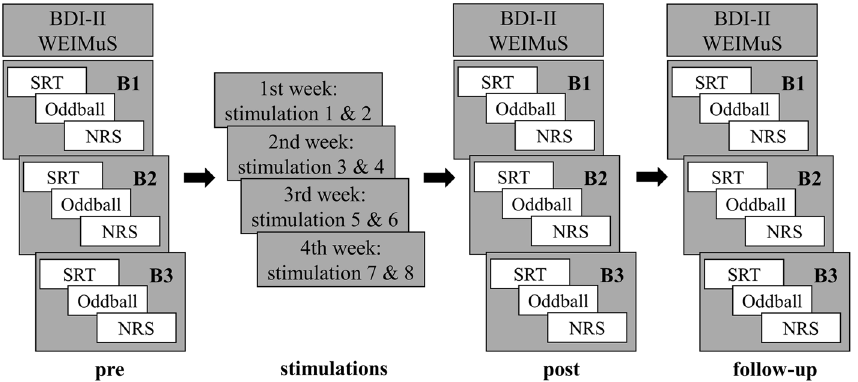
Figure 2. Experimental procedure. The experiment consisted of three experimental sessions with three test blocks each (B1, B2, and B3). In each test block, fatigability and subjective state fatigue scores were assessed. RT variability was evaluated via a serial reaction time task (SRT), P300 during an auditory oddball task, and subjective state fatigue via a 10-point numerical rating scale (NRS). Additionally, depression scores using the Becks Depression Inventory (BDI-II) as well as subjective trait fatigue scores using the Wuerzburger Fatigue Inventory (WEIMuS) were assessed. In between pre- and post-session, eight anodal or sham stimulation sessions were